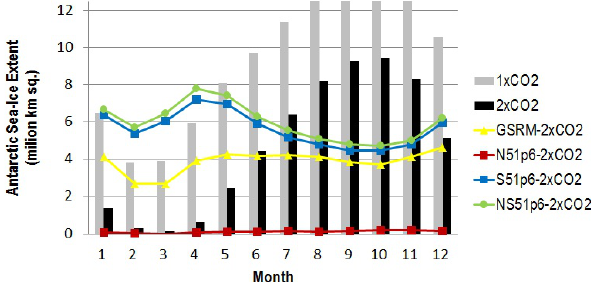
Fig. 6. Monthly variation in Antarctic sea ice extent (in millions of km 2 ) for 1 × CO 2 and 2 × CO 2 and the calculated increments in Antarctic sea ice that would result from a 1.8% reduction in global solar radiation or from 6% reductions in solar radiation from 51 ◦ latitude to the pole in the Northern, Southern, or both Hemispheres, showing that reducing solar radiation by these amounts would, as intended, have the effect of essentially restoring Antarctic sea ice cover, perhaps even